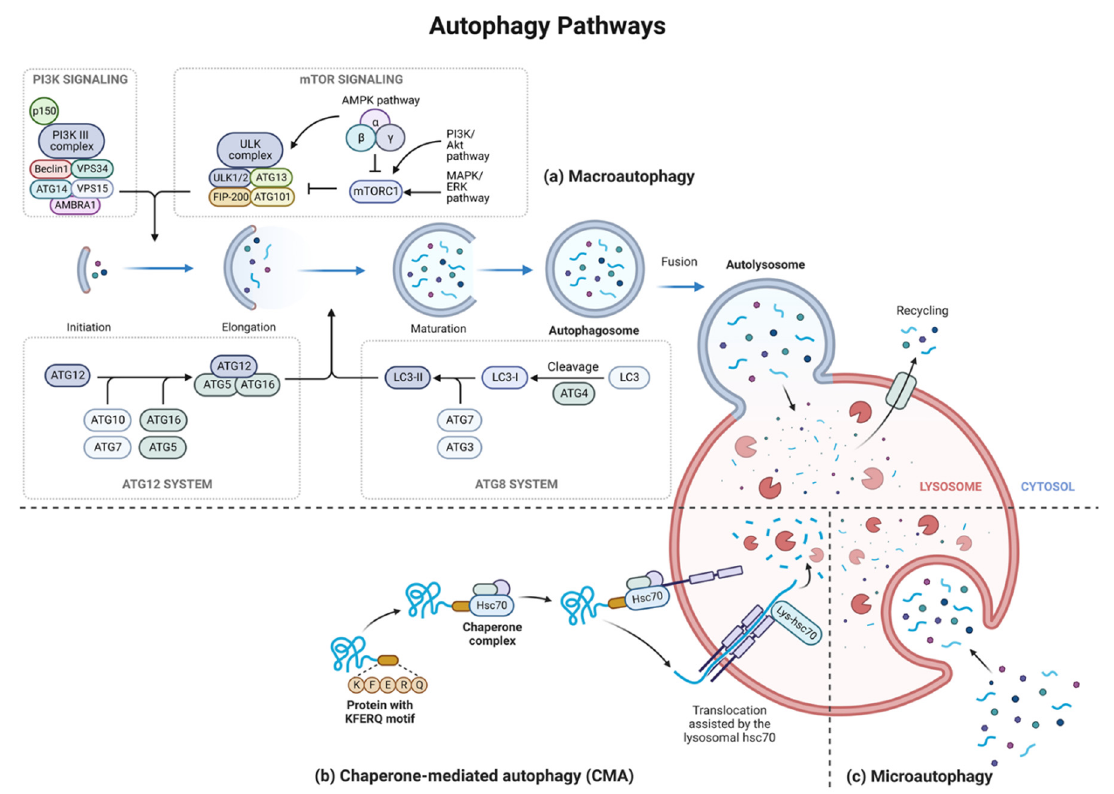
Figure 2. Autophagy pathways in eukaryotic cells is categorized into three main types; ( a ) Macro- autophagy machinery is a complex process that involves multiple steps. The initiation step requires the ULK complex, composed of ULK1/2, ATG13, FIP200, and ATG101. Under favorable conditions, such as nutrient-rich environments, mTORC1 inactivates ULK1/2 and ATG13 through phosphorylation. mTORC1 is inhibited under stressful situations and AMP-activated protein kinase (AMPK) complex, which would lead to macroautophagy induction. The nucleation step requires the phosphorylating class III Phosphatidylinositol-3 kinase (PI3K class III) complex, composed of Beclin1, VPS15 and VPS34, ATG14, and AMBRA1. Maturation and elongation process requires the aid of ubiquitin-like proteins and comprises two major steps. First, the ATG12-ATG5 complex is formed from the covalent binding of ATG 12 and ATG5 with the help of ATG7 (E1-like enzyme) and ATG10 (E2-like enzyme). ATG12-ATG5-ATG16L1 complex is formed after ATG16L1 non-covalently binds to the ATG12-ATG5 complex. In the second step, cysteine-like protease- ATG4 cleaves LC3 to form LC3-I. LC3-I is then activated to LC3-II by ATG7 (E1-like enzyme) and ATG3 (E2-like enzyme), followed by its conjuga- tion with lipid phosphatidylethanolamine (PE) with the help of the ATG12-ATG5-ATG16L1 (E3-like enzyme). The phagophore matures to form an autophagosome and finally fuses with the lysosome creating an autolysosome. ( b ) Chaperone-mediated autophagy (CMA)-HSC70 recognizes proteins with KFERQ-like motifs, and with the aid of other chaperone proteins, they deliver the cytoplasmic protein to the lysosome. The protein binds to LAMP2A and gets translocated inside the lysosome with the help of lys-hsc70. ( c ) microautophagy allows cytoplasmic material to enter the lysosome through a cup-like invagination formed in the lysosome’s membrane. Created using Biorender.com (accessed on 12 December